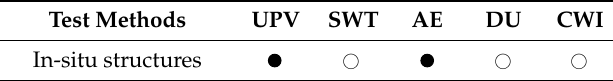
Table 5. Application on in-situ structures for self-healing